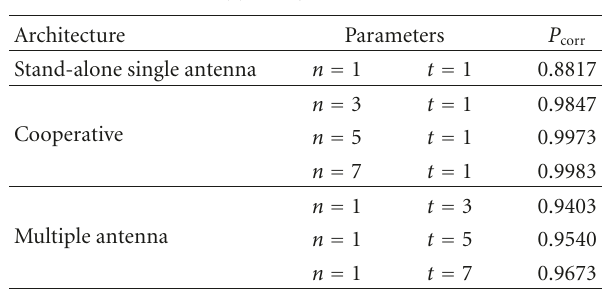
Table 4: Comparison of the performances of the proposed